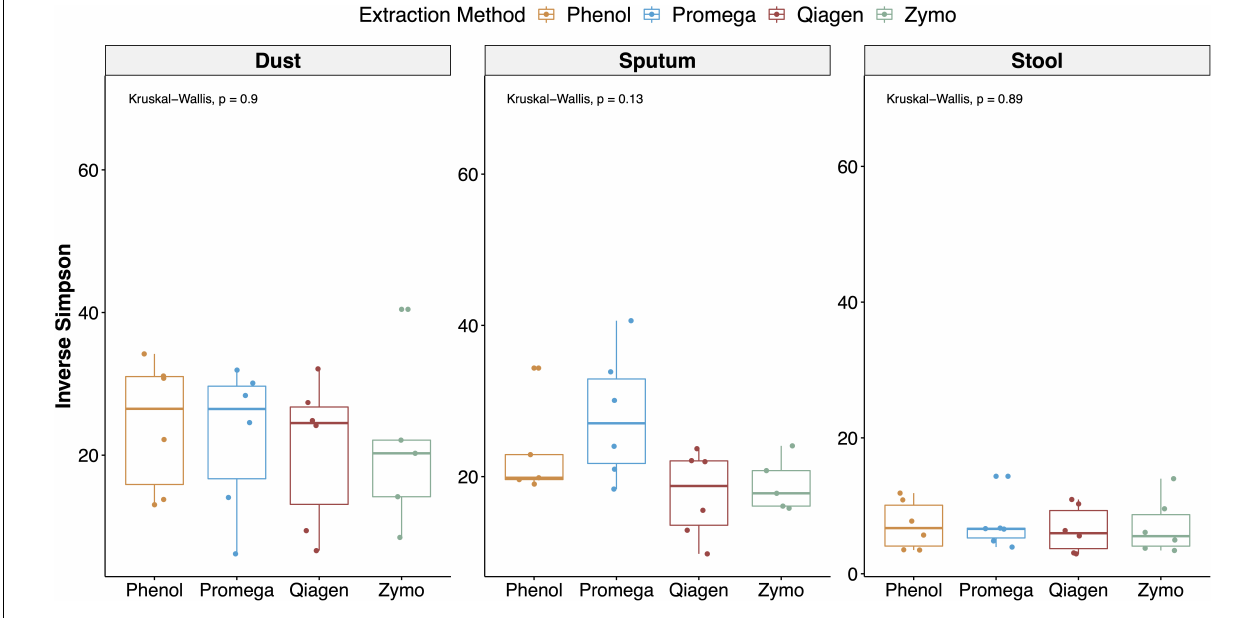
FIGURE 5 | Alpha diversity stratified by sample type and extraction method. The inverse Simpson index (which accounts for both species richness and evenness) was calculated for each sample and aggregate results are depicted with boxplots, stratified by sample type and extraction method. In a linear regression adjusting for sample type, extraction method was not a significant predictor of alpha